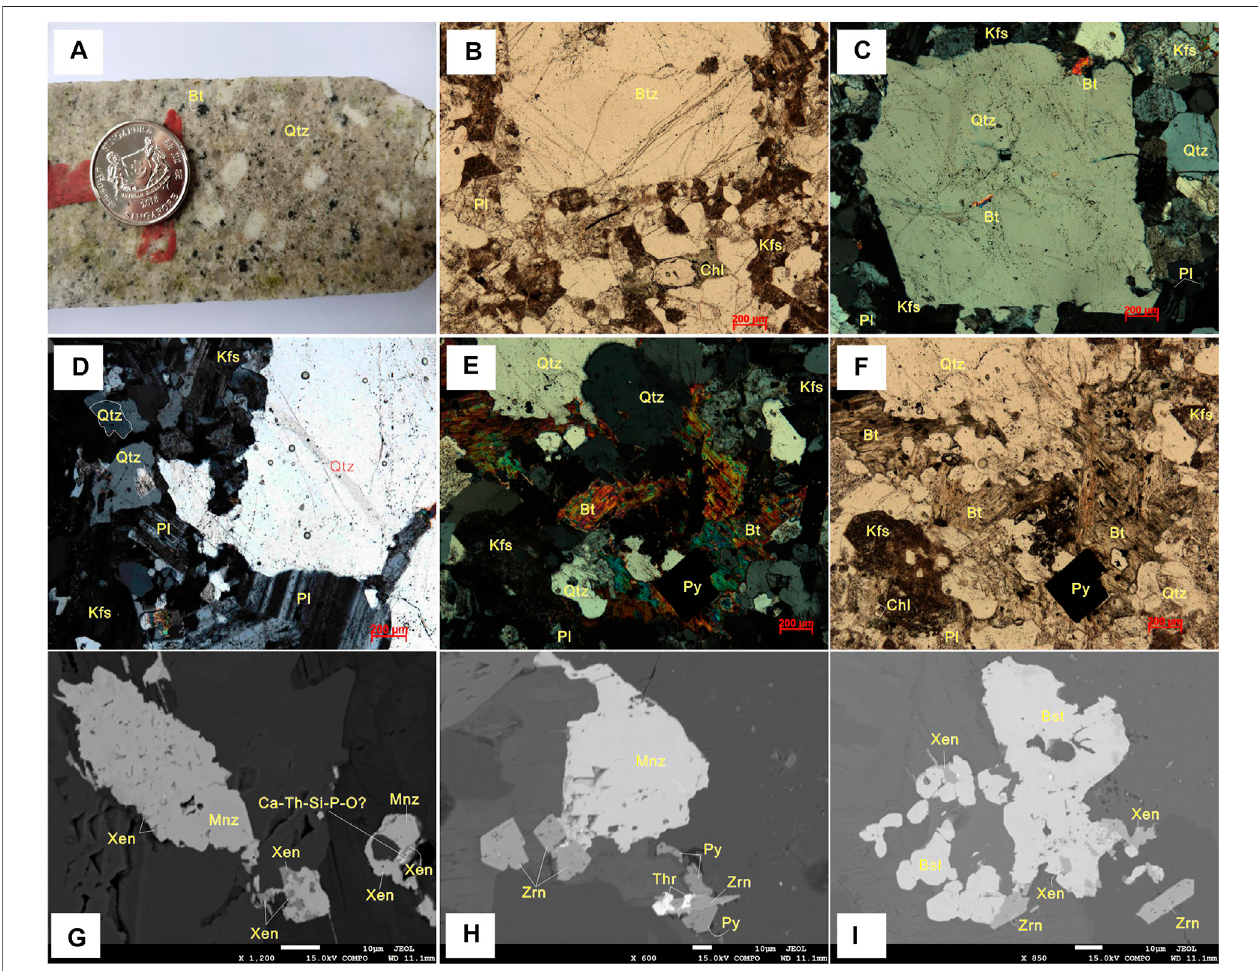
FIGURE 2 | (A) Photograph of the Jianfengling porphyritic biotite monzogranite in the fi eld (B – F) Photomicrographs of porphyritic biotite monzogranite; (G) Monazite replaced by xenotime; (H) Monazite and zircon are co-junction edge structure, and zircon replaced by thorite and late pyrite; (I) Bastnasite replaced by xenotime and zircon. Pl, plagioclase; Kfs, K-feldspar; Qtz, quartz; Bt, biotite; Mnz, monazite; Py, pyrite; Zrn, zircon; Bst, bastnasite; Xen, xenotime; Thr, thorite.